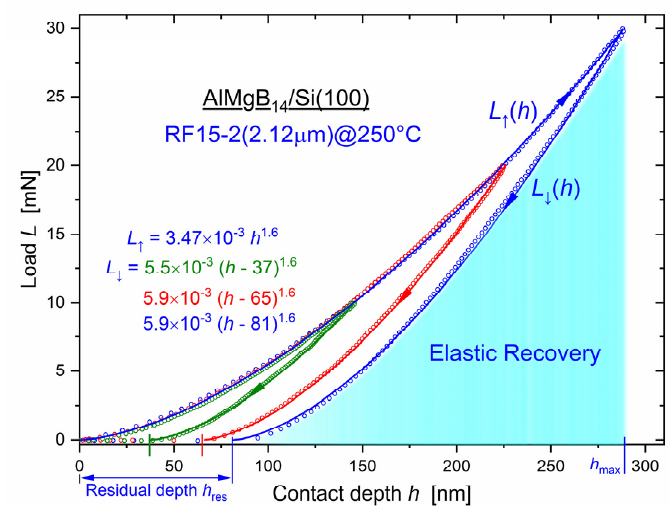
Figure 4. Load-displacement curves of the hard RF15-2(2.12 µ m) AlMgB 14 film grown onto Si(100) substrate at 250 ◦ C. Solid lines fit loading L ↑ ( h ) (ascending) and unloading L ↓ ( h ) (descending) experimental data shown with symbols. Area between L ↑ ( h ) and L ↓ ( h ) curves corresponds to plastic deformations whereas the colored section depicts the area of elastic recovery.